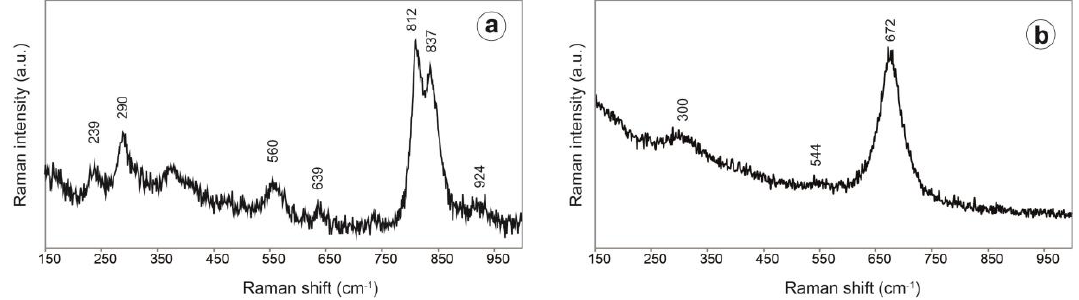
Figure 5. Raman spectra ( a ) Olivine spectrum. ( b ) White skins spectrum.